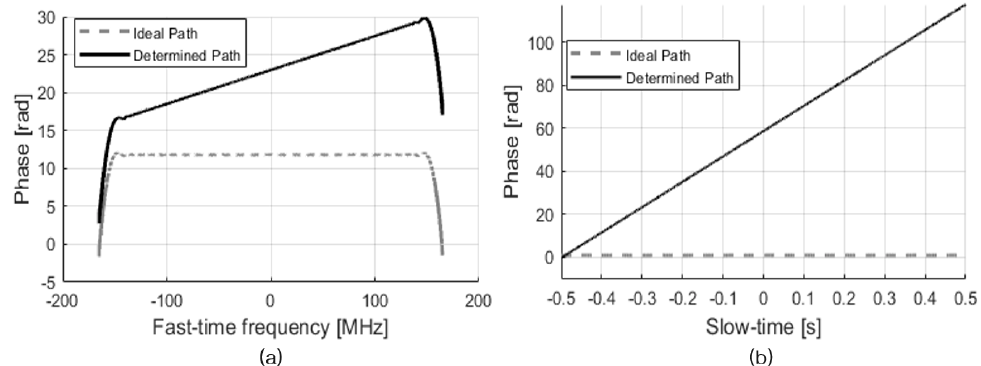
Figure 20. Phases of the received signal that has completed signal compressions in the range and azimuth directions. Fast-time frequency domain for the range direction ( a ) and slow-time domain for the azimuth direction ( b ). The solid and dotted lines represent the phase of the received signal under the determined and designed orbits, respectively.